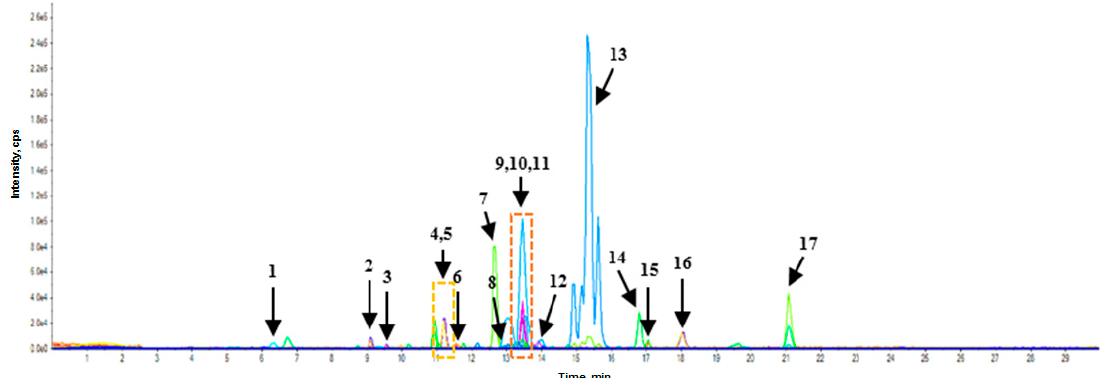
Figure 2. MRM ion chromatogram of control roasted soybean flour (RSF). ( 1 ) L -phenylalanine; ( 2 )